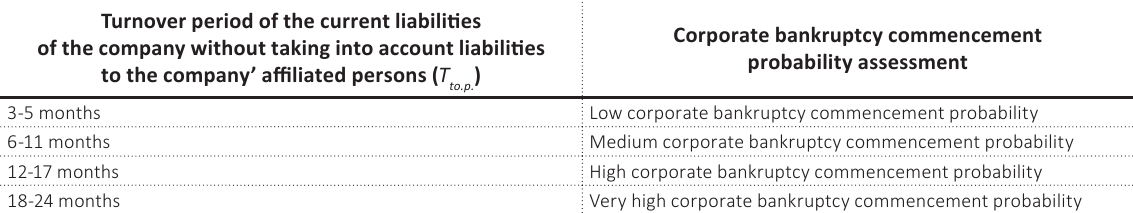
Source: Developed by the authors.